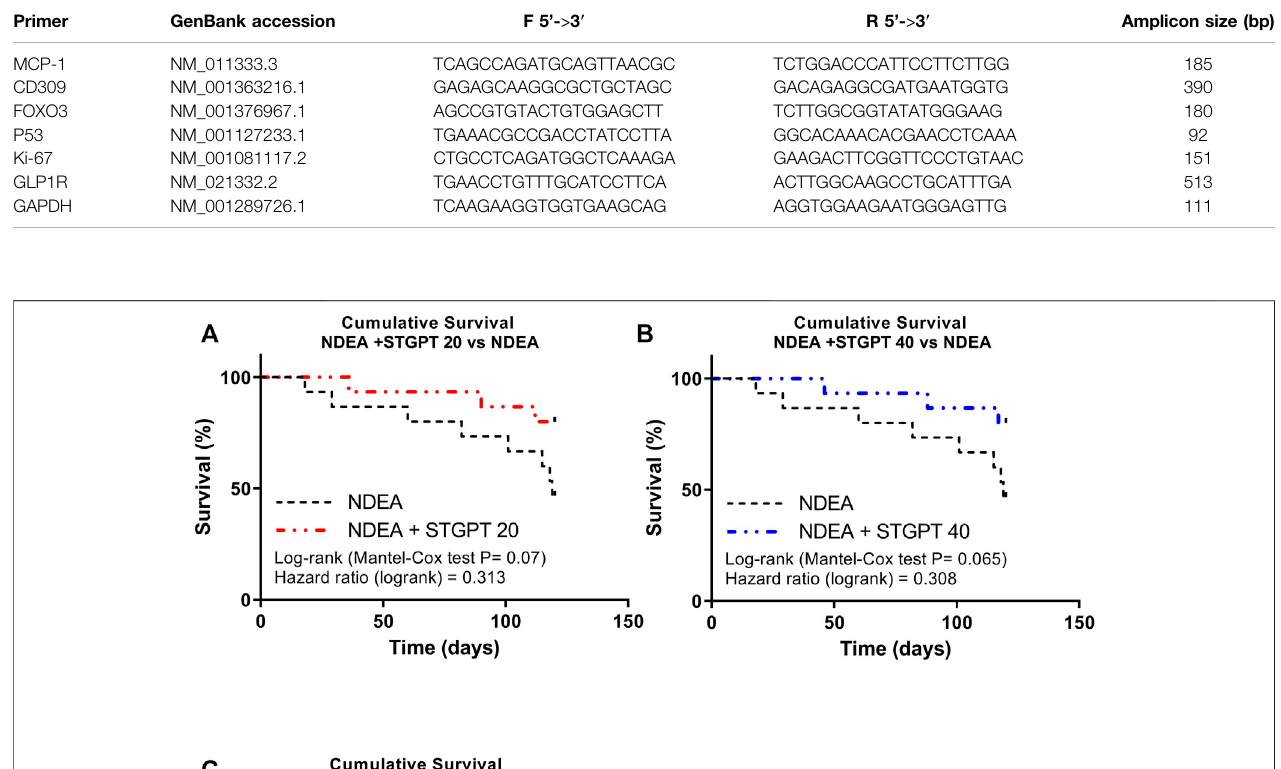
Frontiers in Pharmacology |